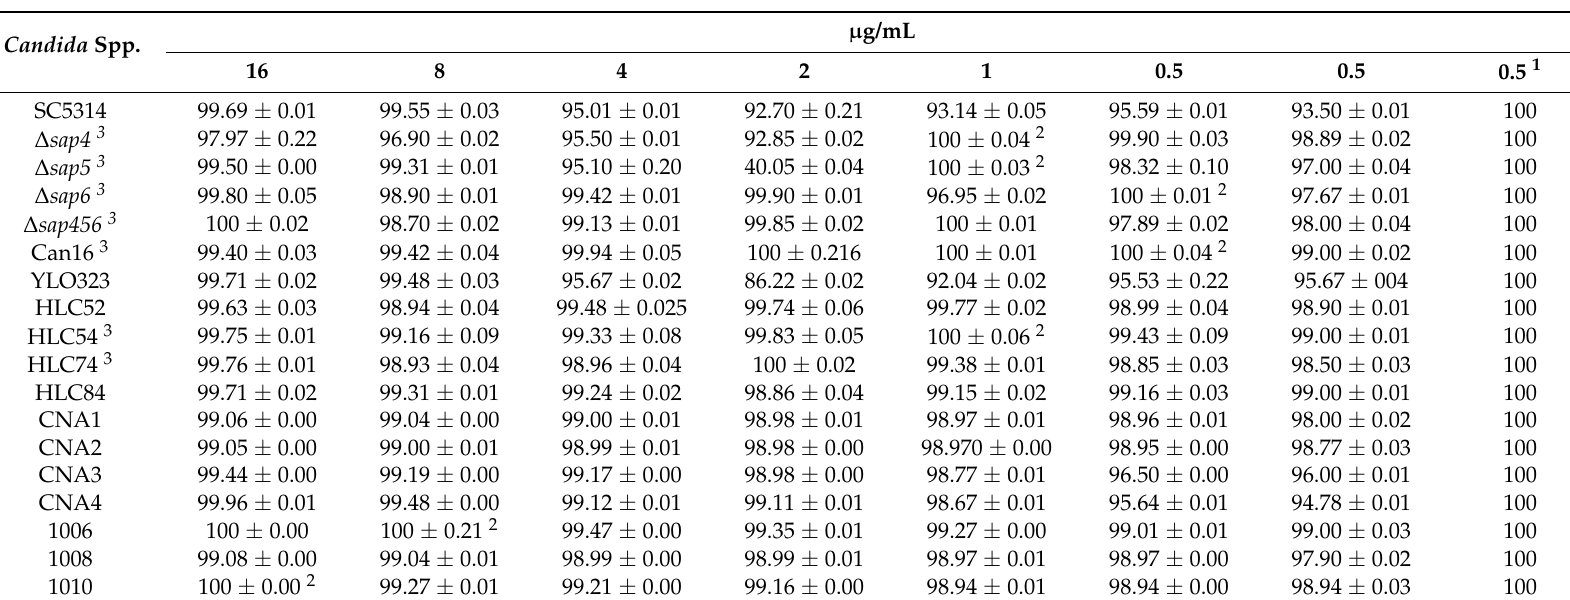
Table 3. Antifungal activity (cell inhibition %; Means ± SD) of 2 bromo-2-chloro-2-(-4-chlorophenyl sulfonyl)-1-phenyloethanon (Compound 4 ) against Candida strains after 48 h tested by using method M27-A3 [20]. Candida